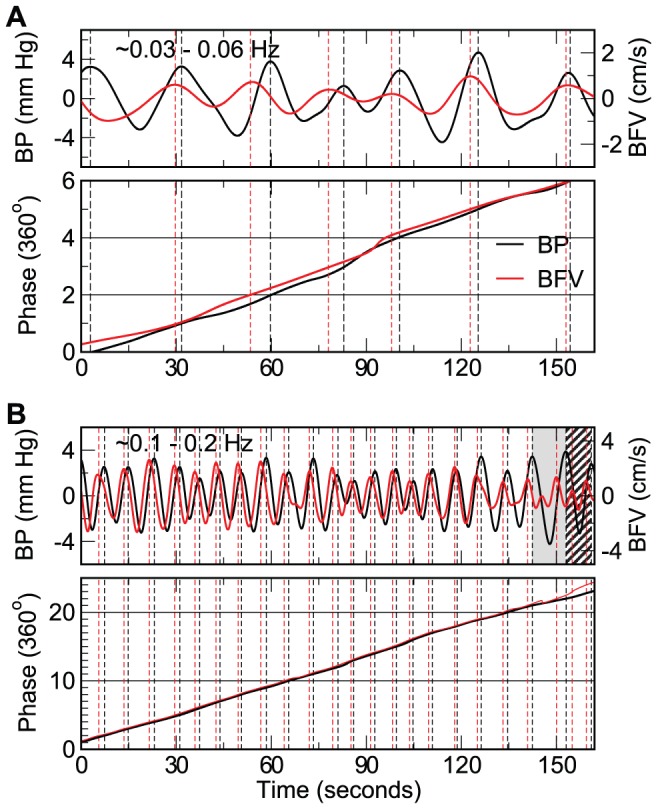
Phase interaction between intrinsic oscillations of cerebral blood flow velocity (BFV) and blood pressure (BP) at different time scales or frequencies.Examples of extracted BP and BFV components, and their instantaneous phases at ∼0.03–0.06 Hz (A) and ∼0.1–0.2 Hz (B). Oscillatory components were extracted from original BP and BFV signals using the empirical decomposition method and their instantaneous phases were obtained using the Hilbert transform. Individual cycles (separated by dashed lines) are identified based on instantaneous phases and each cycle corresponds to a phase increase of 360°. In each extracted component, oscillations are not stationary with varying amplitude and period. Generally, the phase of BFV oscillations was advanced compared to the phase of the corresponding BP oscillations. Data in the last two BP cycles in B were excluded because either (i) instantaneous phases BFV decreased as characterized by an extra oscillation under the zero line (the grey-highlighted cycle; see Criterion 1); or (ii) the BP period was significantly greater (>1.5 times) compared to the BFV period (the hatched cycle; see Criterion 3).